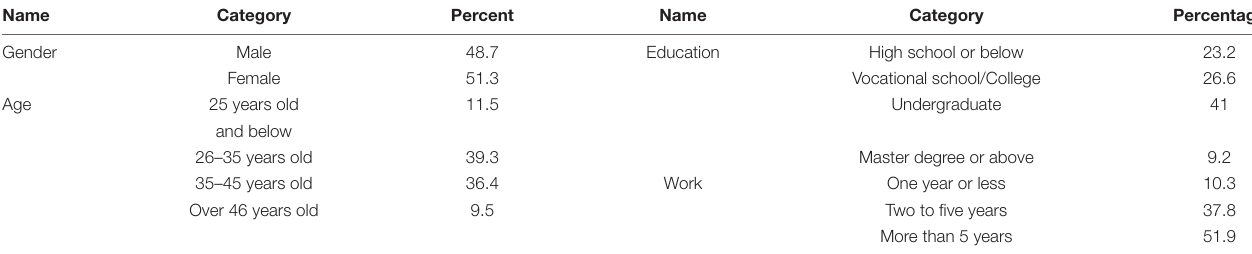
TABLE 1 | Composition of valid samples ( N = 349).